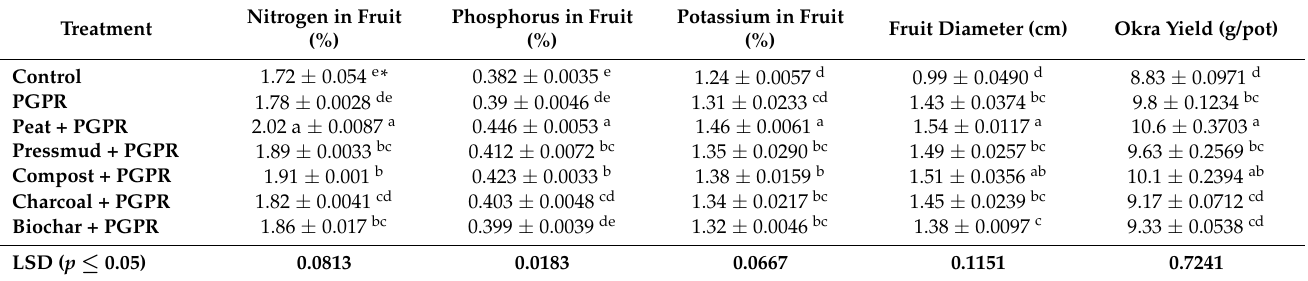
Table 4. Effect of different carrier materials on yield parameters of okra in pot trial. Values are mean ± standard error of three replications.